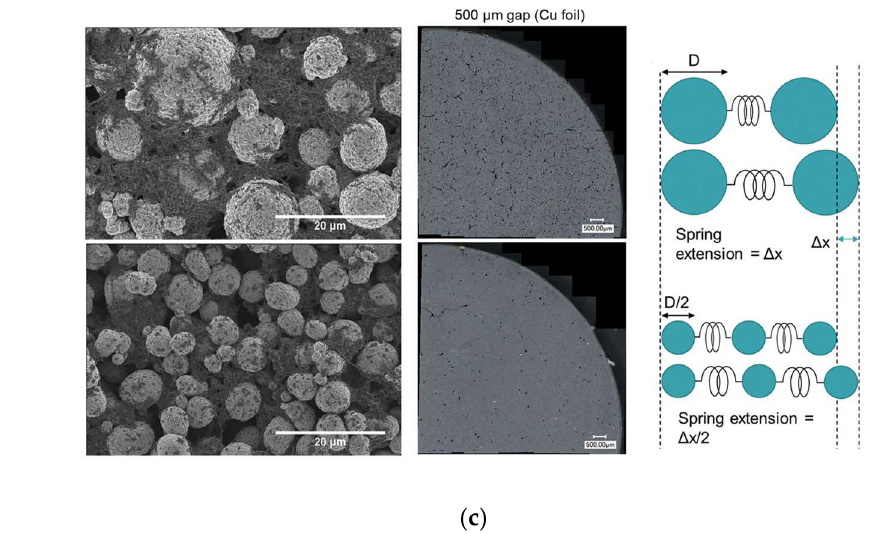
Figure 4. ( a ) Calculated surface tension of IPA–water mixture versus composition [41]. ( b ) Schematic of the wet film and dry film [45]. ( c ) SEM and optical microscope images of aqueous-processed cathode coatings (500 µ m coating wet gap) on copper foil. Additionally, a simple ball and spring model is given